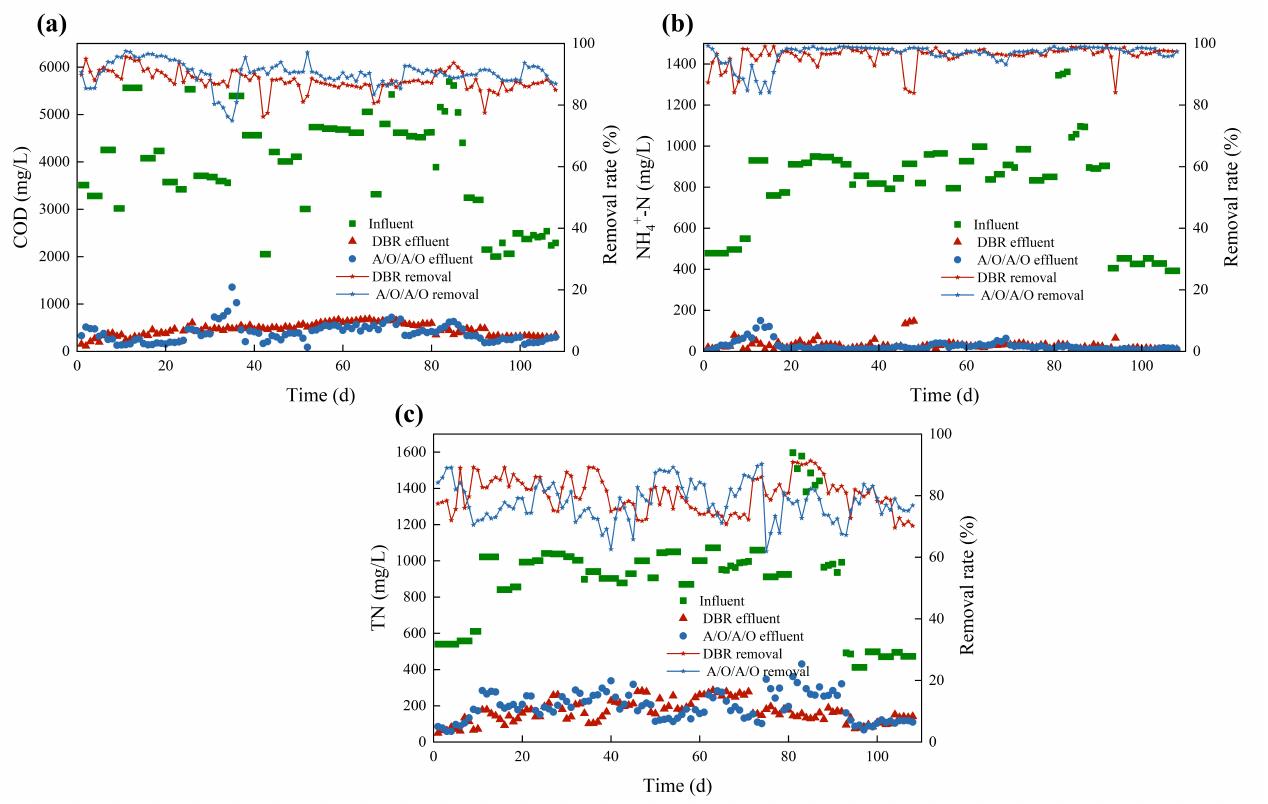
Figure 2. Concentration and removal rate of COD ( a ), NH + A/O/A/O systems.